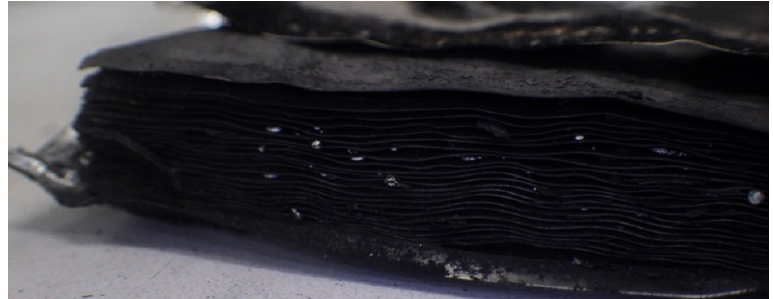
Figure 14. The pouch cell after TR was opened on the welded sides. Droplets were visible between the stacked cell layers.